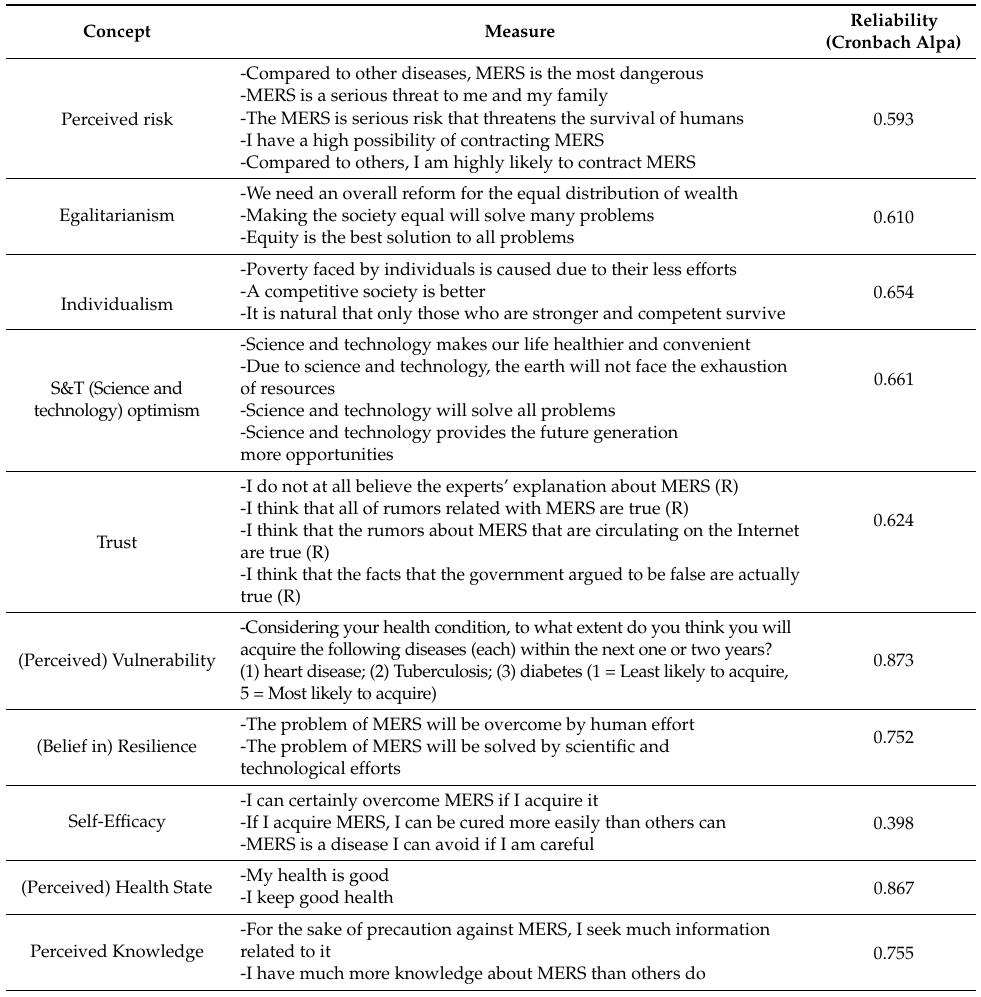
Table 2. Measures and reliability of dependent/independent